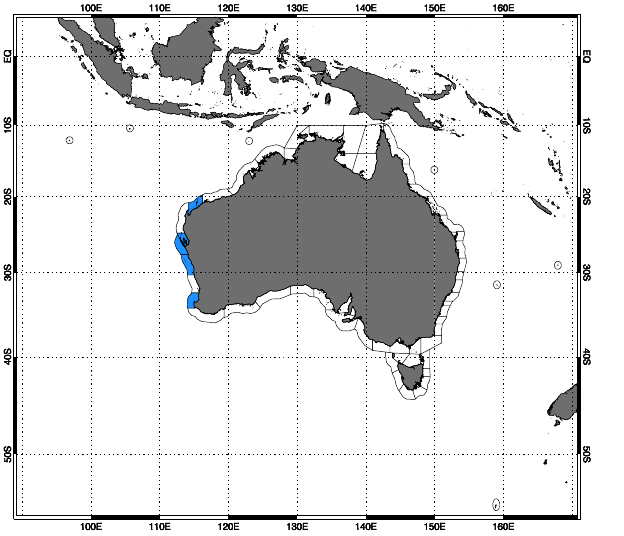
Fig. 12. Derived T2 warnings for the Java 2006 event based on the thresholds in Sect. 3.2. Coastal zones assigned a marine threat are shaded in